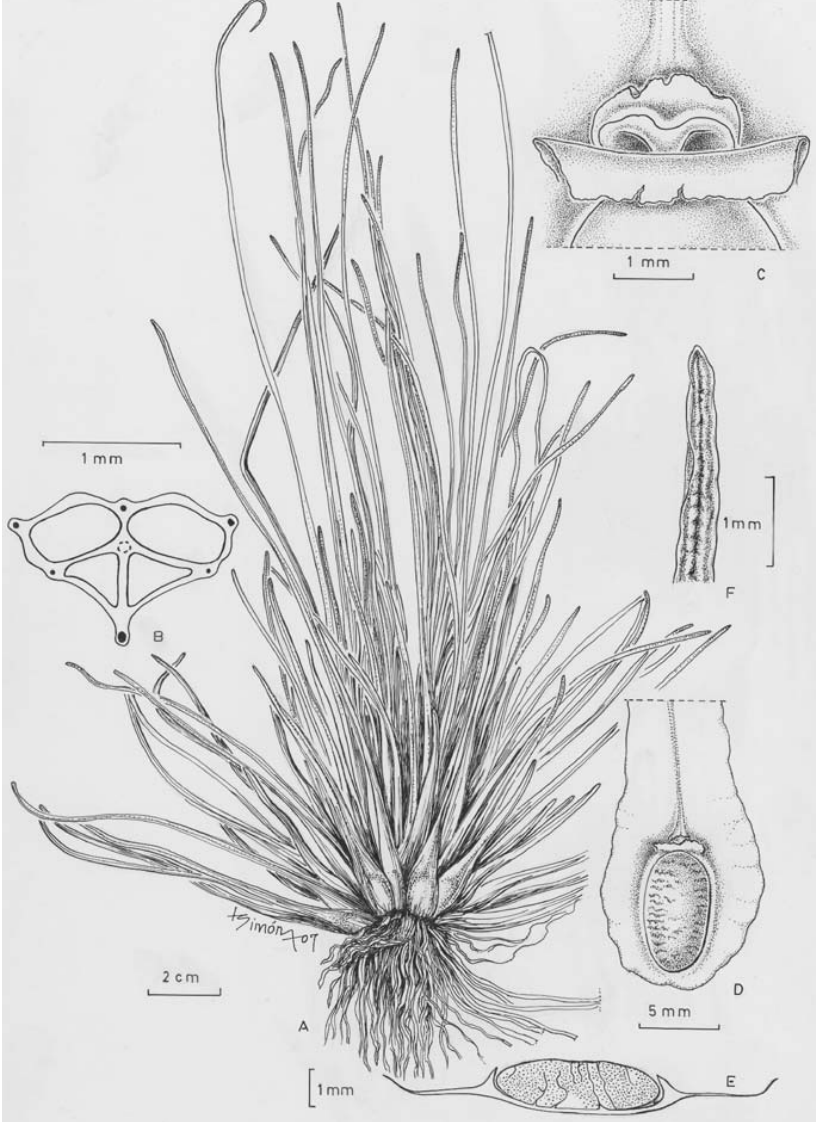
Fig. 1 – Isoetes pedersenii . A – Plant habit. B – Cross section of the subula (terminal region of a microphyll), with 4 air chambers, fiber bundles (black circles) and vascular tissue (cut line). C – Detail of the labium folded in order to let the ligule remnant be seen. D – Basal portion of a microphyll with megasporangium. E – Cross section of microsporangium, with trabeculae arranged transversely. F – Detail of the subula apex. ( Pedersen 8105 , CTES).